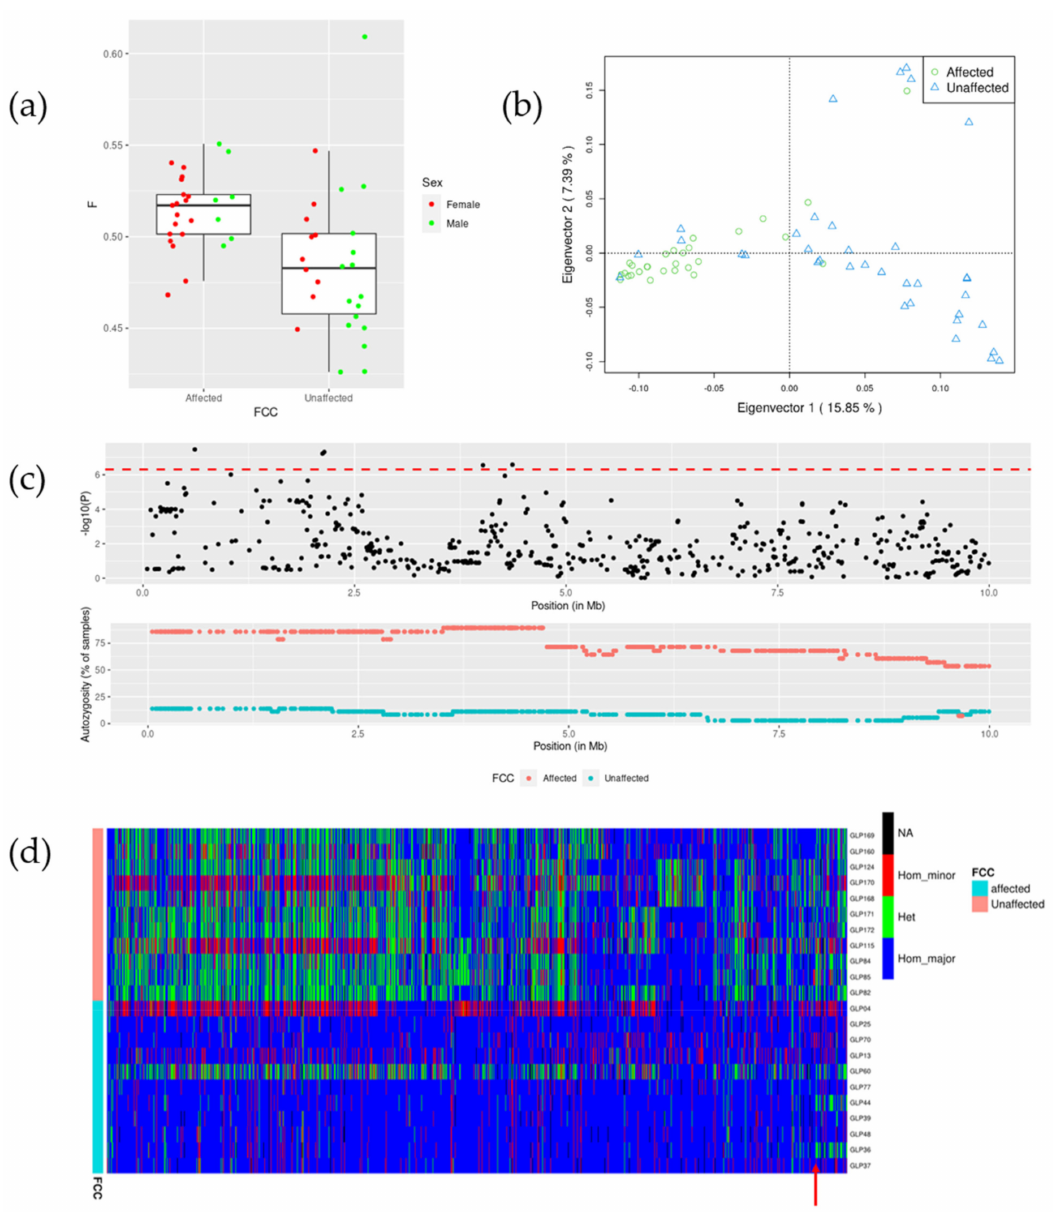
Figure 1. ( a ) Inbreeding coefficient of affected and unaffected dogs based on SNP chip genotype data. ( b ) PCA plot. First and second components are plotted for 28 affected and 36 unaffected GLPs used in the GWAS analysis. Most affected dogs are clustered apart from unaffected dogs, indicating clear population stratification. ( c ) Manhattan plot and autozygosity of ROH segments in affected and unaffected GLPs in the region between 1–10 Mb on chr17. The red dashed line in the Manhattan plot denotes the Bonferroni corrected significance threshold. ( d ) Genotypes of the variants between 0 and 5 Mb on chromosome 17 identified by WGS from 22 dogs. Colors blue, green, red, and black denote homozygous for major allele, heterozygous, homozygous for minor allele, and missing genotype,